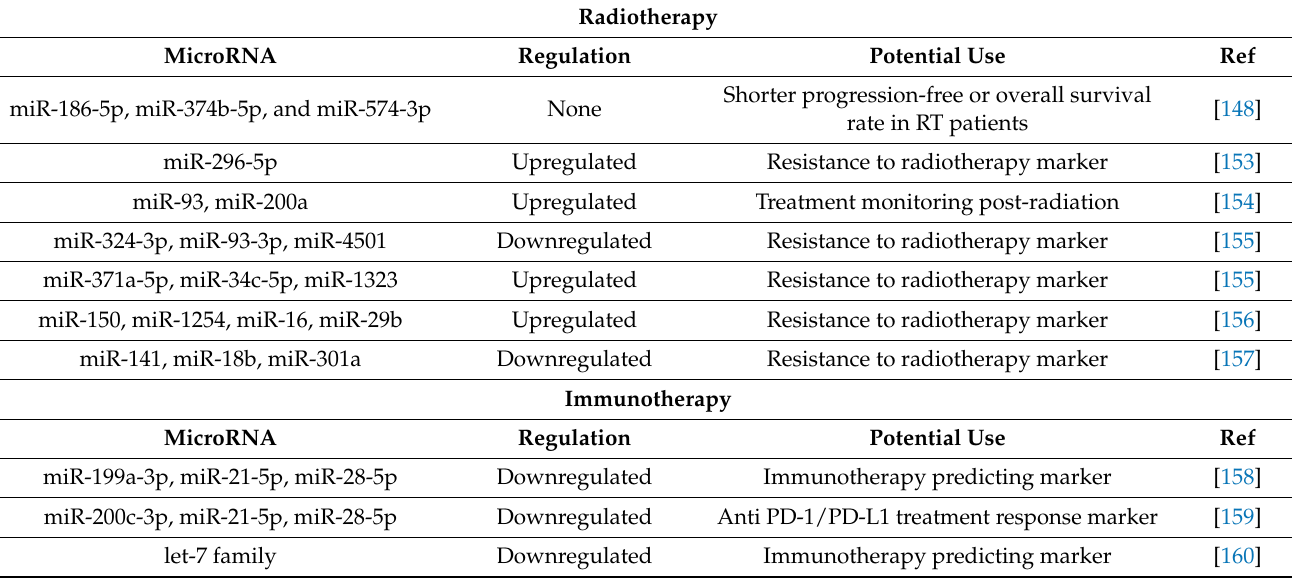
Table 2. MicroRNA as radiotherapy and immunotherapy